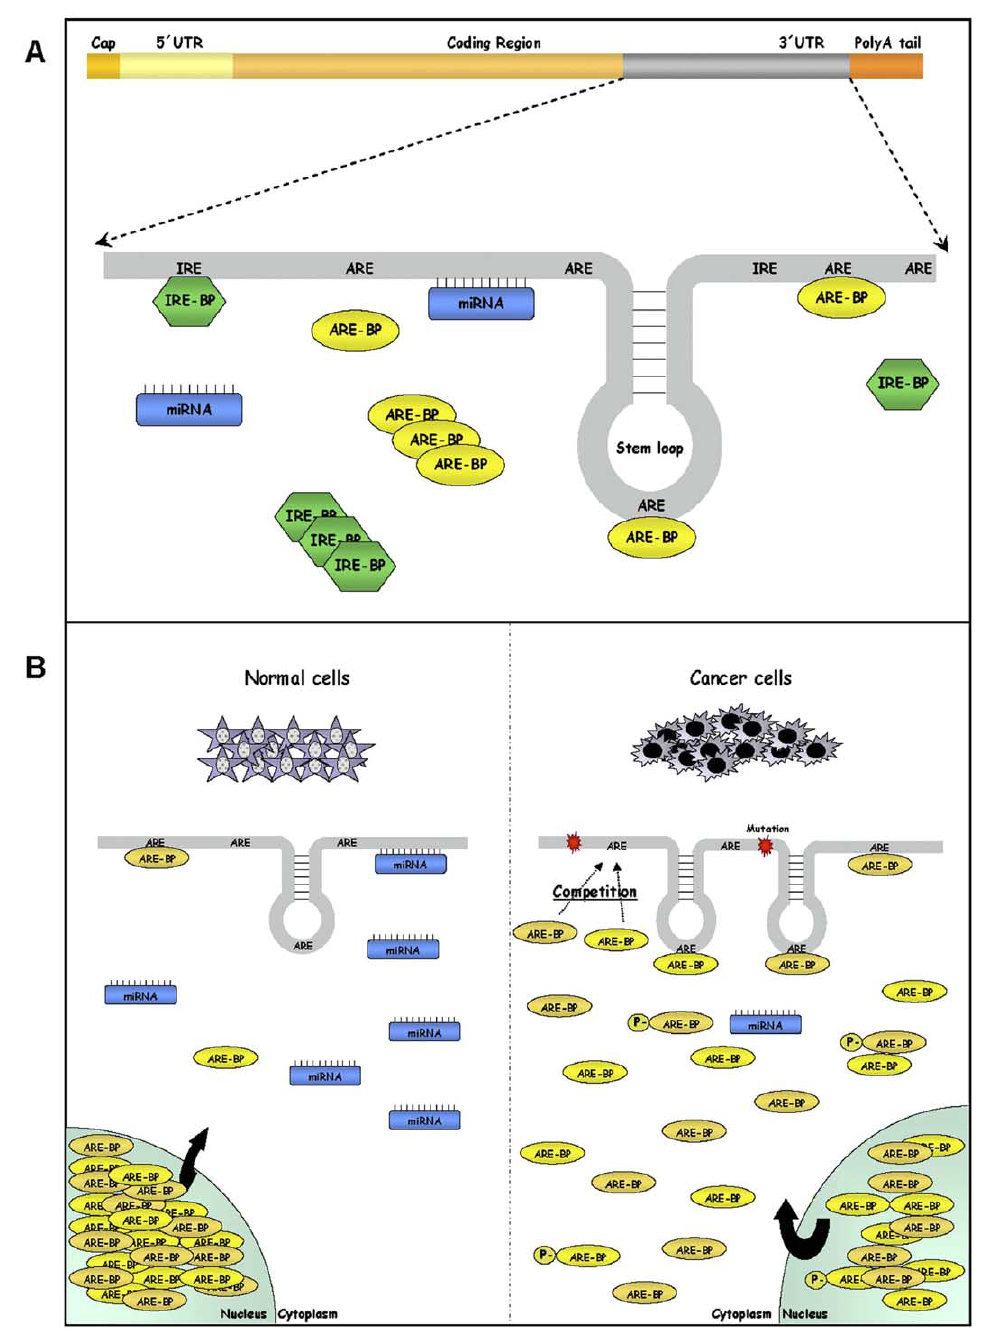
Fig. 2. 3 (cid:2) UTR determinants and their alterations in cancer. (A) Schematic of the different regions in the mRNA. The 3 (cid:2) UTR is enlarged to show the cis -elements (AREs, IREs and secondary structures) that are found in this region and the trans -acting factors (RNA-binding proteins and non-coding RNAs) that associate to them. (B) In cancer cells, two main groups of aberrant 3 (cid:2) UTR regulation can be found: (1) Genetic alterations in cis -elements such as mutations, deletions, translocations and polymorphisms and (2) Altered levels of trans -acting factors (e.g. increase of ARE-BPs and decrease miRNAs levels), changes in their subcellular localization (e.g. increased cytoplasmic levels of ARE-BPs) or their posttranslational modifications (e.g. phosphorylation of ARE-BPs). ARE-BPs: AU-rich binding proteins. miRNAs: microRNAs. ARE: AU-rich